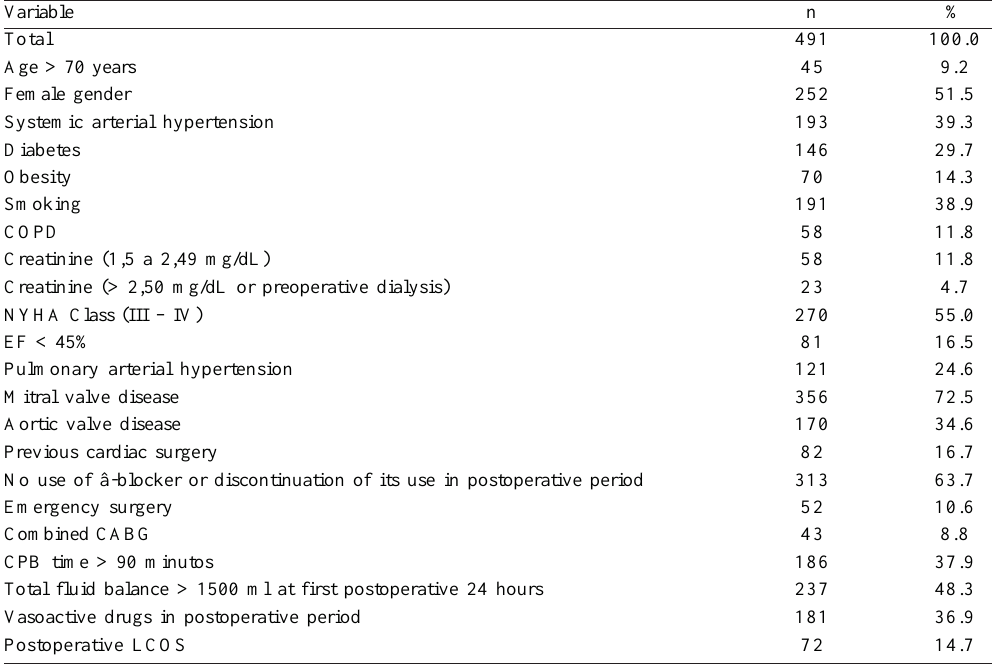
Table 1. Clinical and surgical profile of studied population